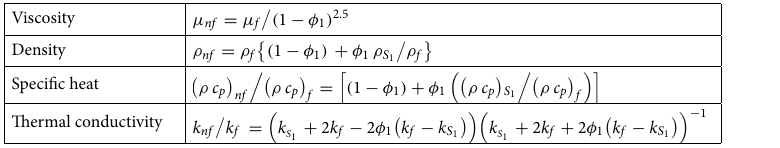
Thermal Table 1. Thermo-physical traits of TiO 2 / blood nanofluid 11,36 .